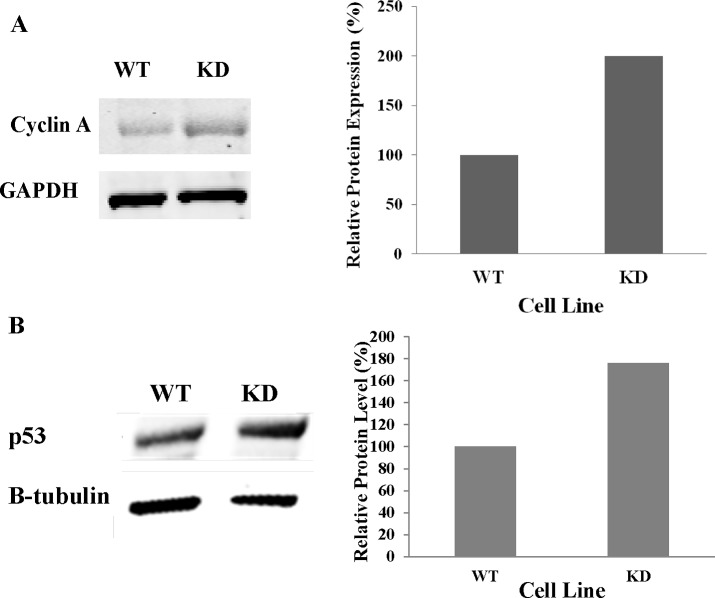
Knockdown of CDK2AP1 in hESCs increases Cyclin A and p53 protein levels.A. Western blot (left) shows an increase in Cyclin A levels in the CDK2AP1 knockdown hESCs when compared to wild type cells. Densitometric analysis of the protein levels of the Western blot is presented in the right panel. B. Whole cell lysates of wild type and CDK2AP1 knockdown WA09 hESCs were examined for p53 protein levels. We found that knockdown of CDK2AP1 increased p53 protein levels as shown by the western blot (left). Densitometric analysis of the protein level is presented in the right panel.